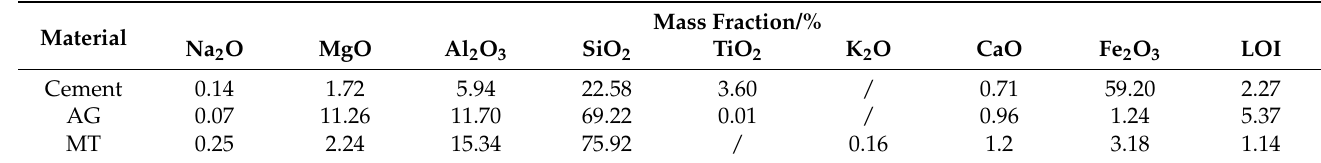
Table 2. Main chemical compositions of Portland cement (OPC), attapulgite (AG) and montmoril- lonite (MT).